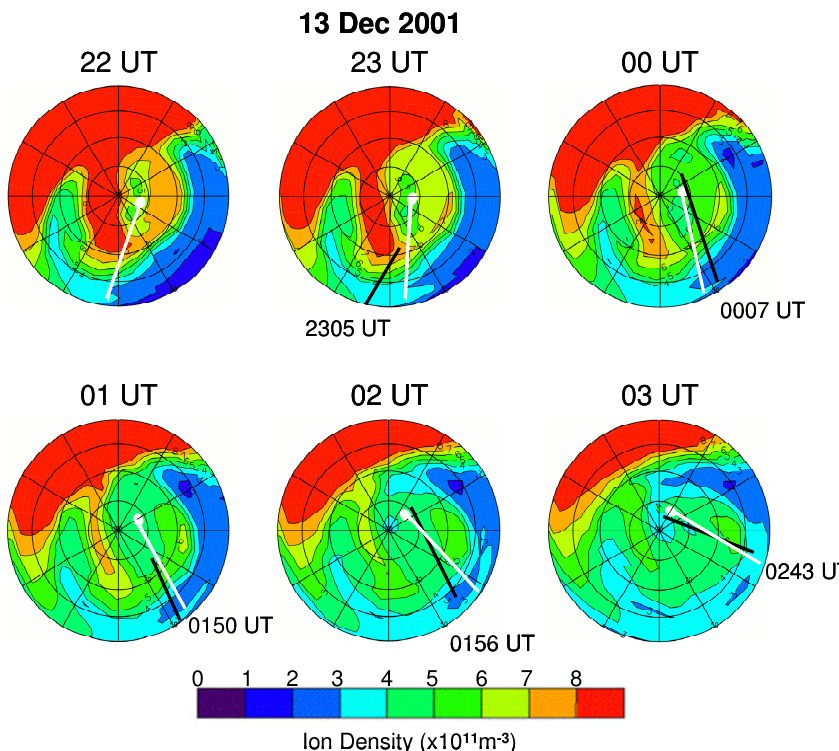
Fig. 5. Ion densities modelled by CTIP from 22:00UT to 03:00UT for 13 December 2001. The panels are at hourly intervals of UT, with each panel showing the ion density distribution at an altitude of 320km, near the F-region ionisation peak, as a function of MLAT and MLT. The format of the panels is the same as for Fig. 4, with the white line showing the 18 ◦ E meridian near the longitude of the Scandinavian tomography chain. The black lines indicate the 300km trajectory intersections of the satellite passes of the reconstructions.